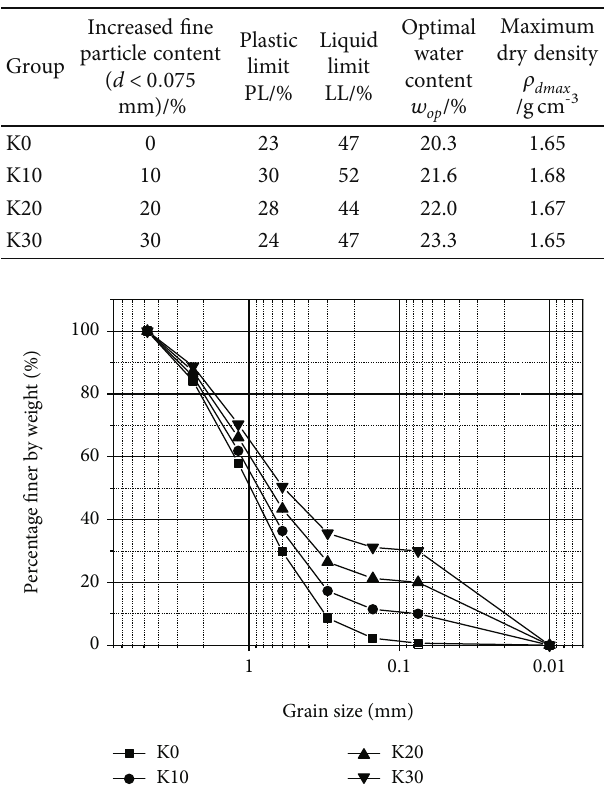
Figure 2: Particle size distribution curves.